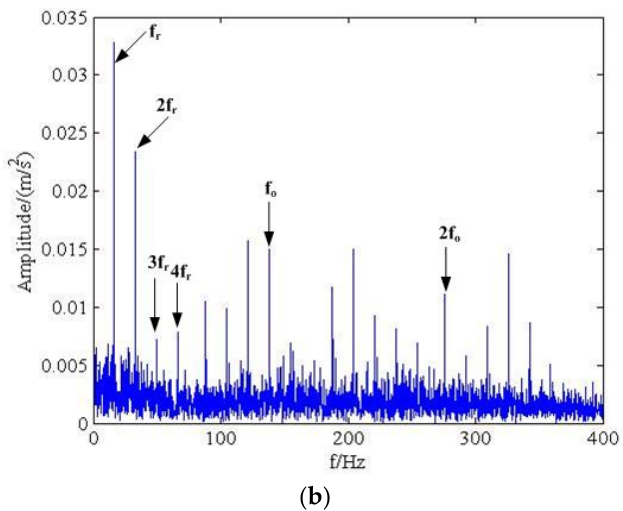
Figure 10. Result obtained by the proposed method. ( a ) Result of proposed method in time ‐ domain; ( b ) Result of proposed method in frequency ‐ domain.